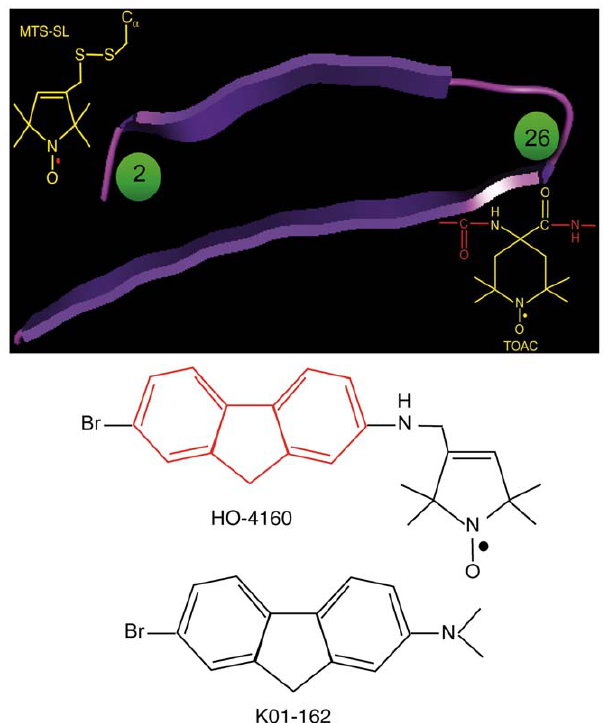
Figure 1. Diagram showing the locations of spin labels in A b (1–40) , and the structures of the HO-4160 and K01-162 fluorene compounds. Top panel:. the spin labels were targeted to either position 2 (MTS nitroxide spin label) or position 26 (TOAC nitroxide spin label) of A b . Position 26 lies within a putative hairpin loop connecting the terminal domains of the peptide, while position 2 is found within the N-terminal domain. Bottom panel: the structure of the SLF compound HO-4160, which is a derivative of the active fluorene K01- 162 described in [6]. The core fluorene ring structure is shown in red.